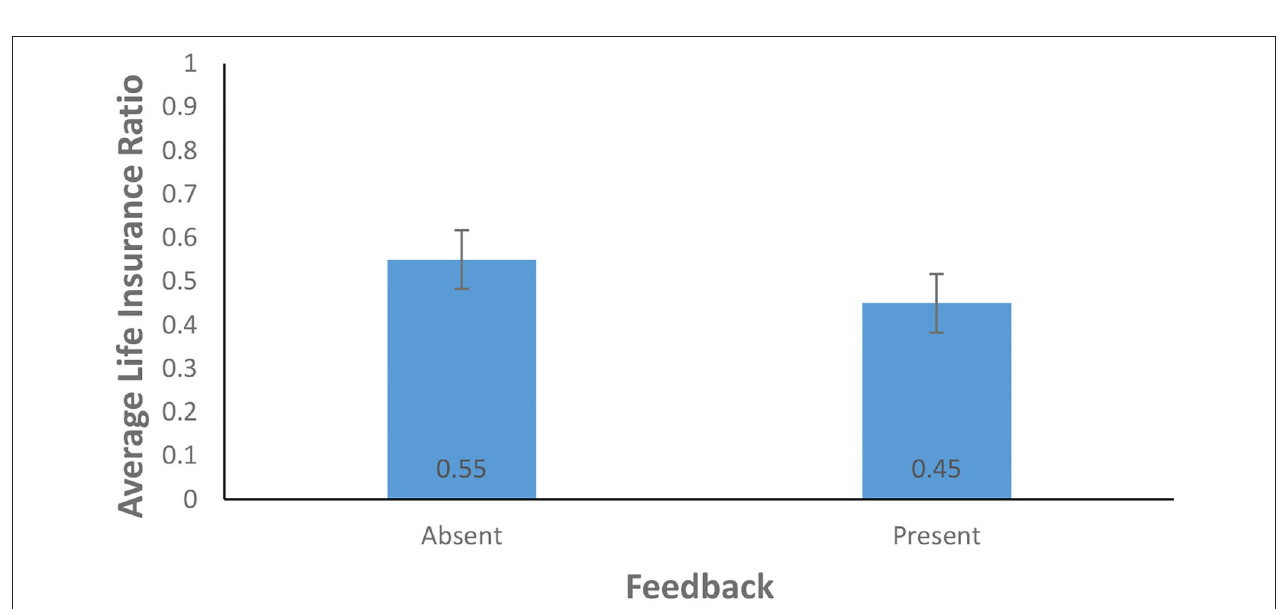
FIGURE 7 | Average life insurance ratio in feedback-present and absent conditions. The error bars show 95% CI around the point estimate.